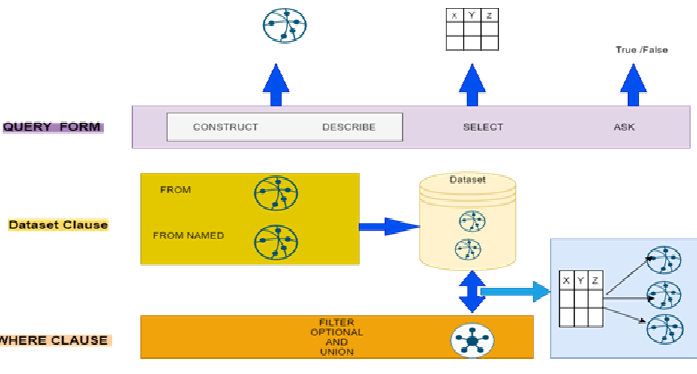
Figure 2. Forms of SPARQL query.